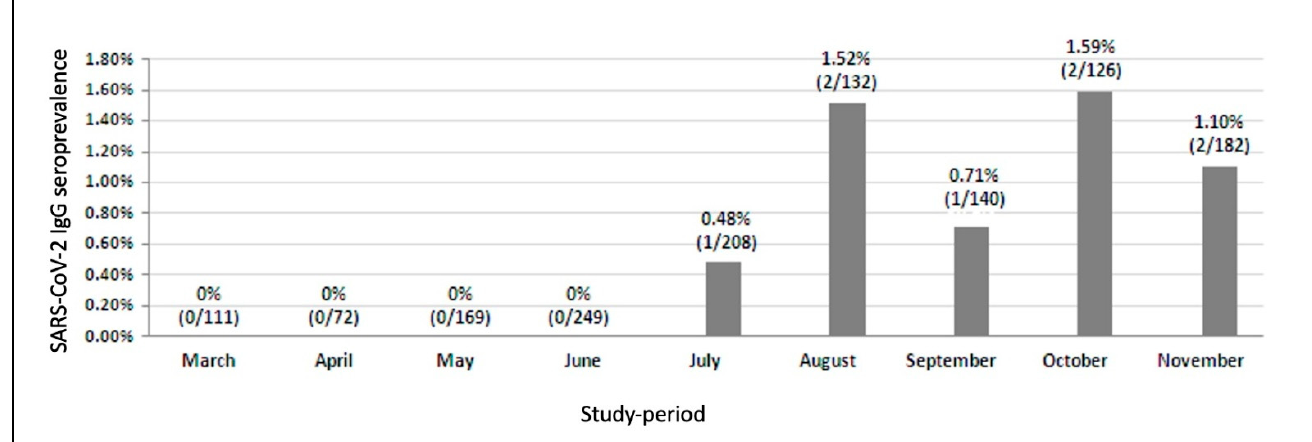
Figure 1. Month by month anti SARS-CoV-2 IgG seroprevalence. Seroprevalence was calculated as the number of ‘truly’ positive tests/total patients × 100.